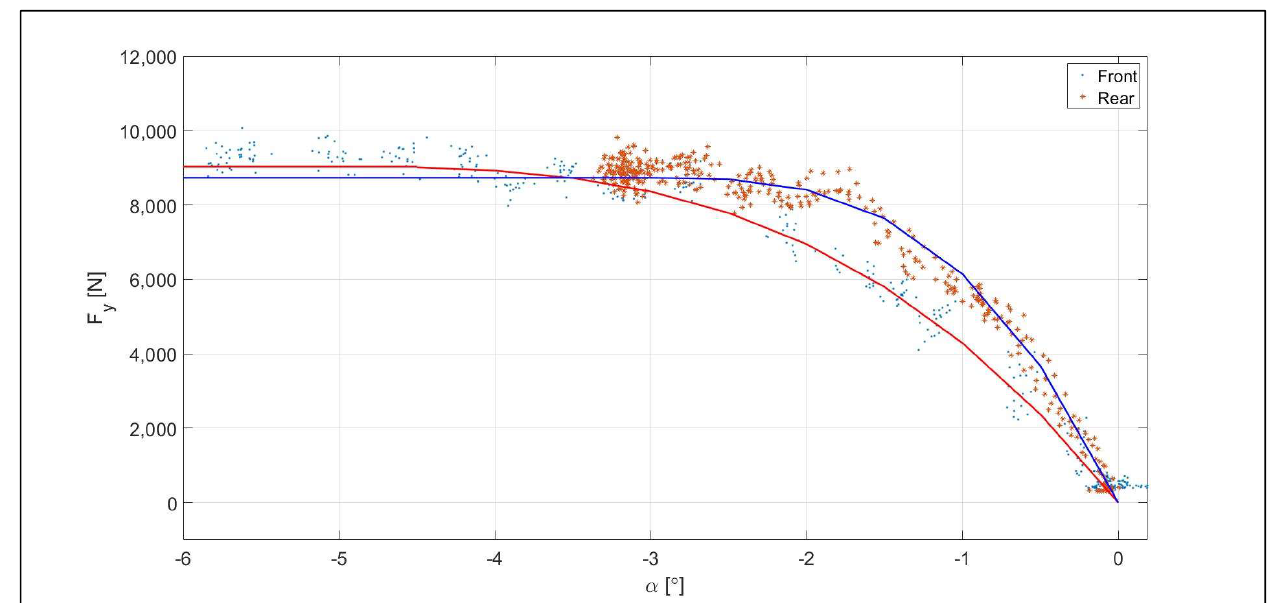
Figure 2. The measured tire curves for the front and rear tires.